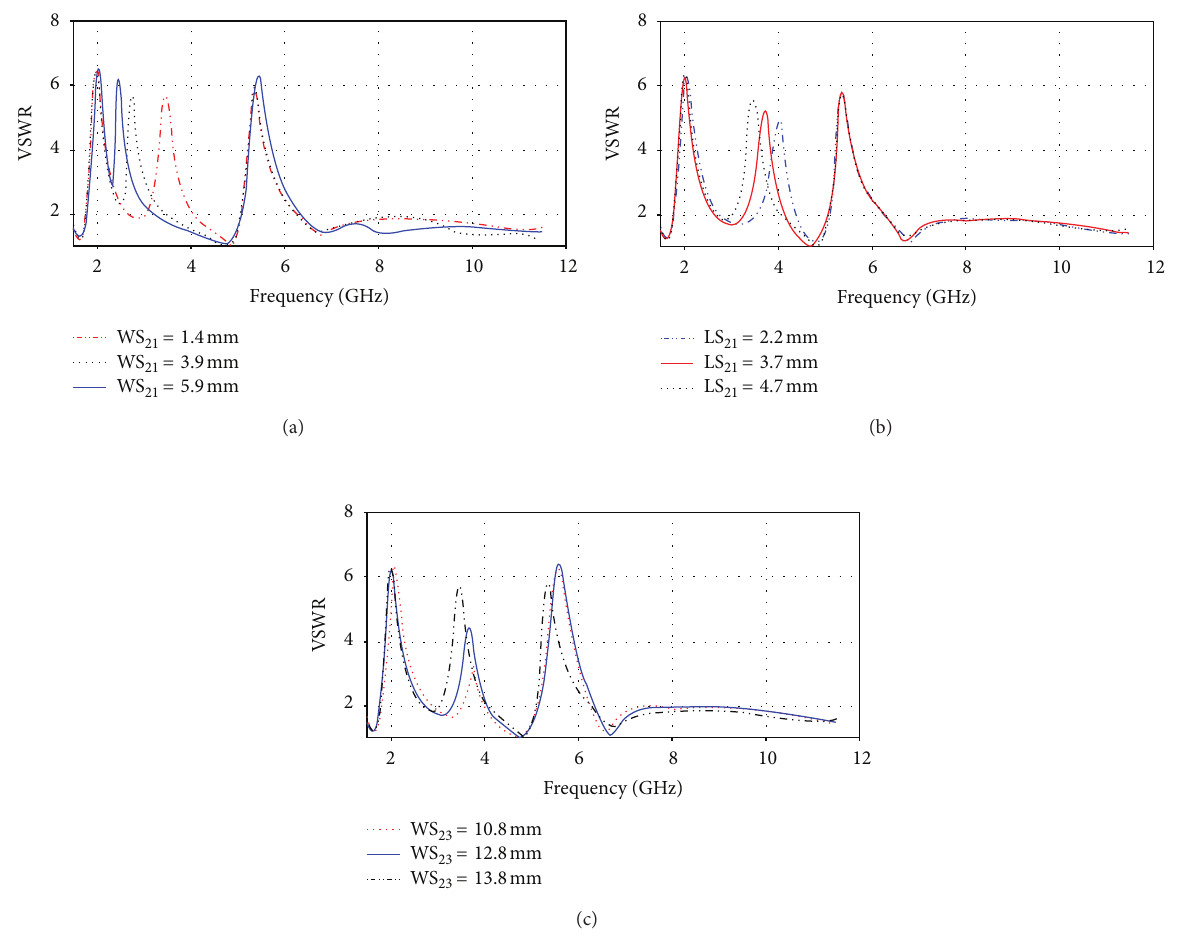
Figure 6: The simulated VSWR of the proposed antenna: effects of some parameters on the 3.54 GHz band-notched function, (a) WS 21 , (b) LS 21 , (c) WS 23 .